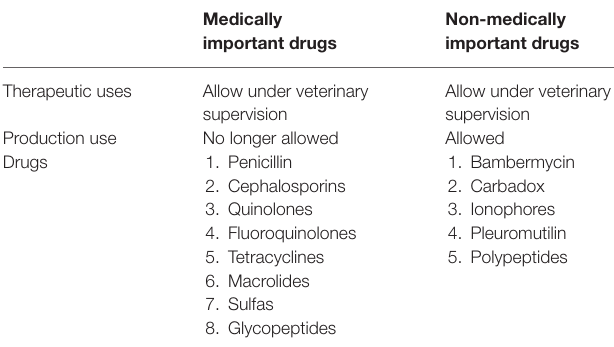
TABLE 1 | Veterinary feed directive